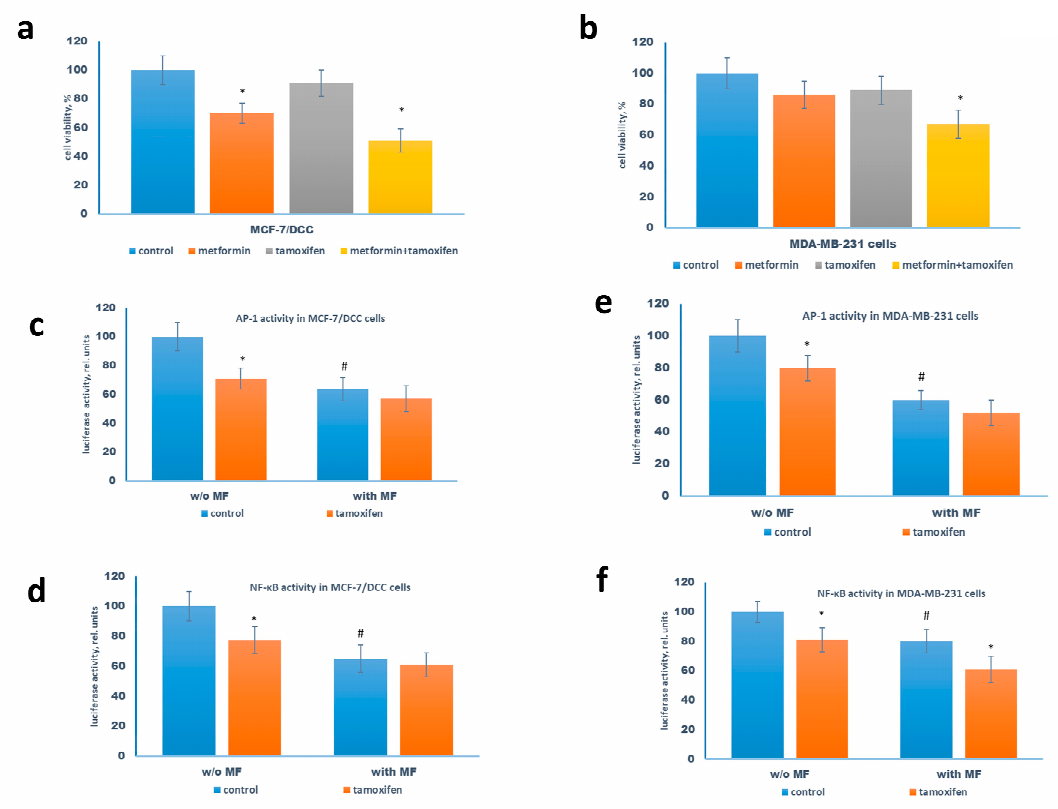
Figure 7. The sensitivity of MCF-7/DCC cells and MDA-MB-231 cells to tamoxifen. ( a , b ) Growth response. The cells were treated without or with 5 µM tamoxifen in the presence or absence 2 mM metformin for 3 days in phenol-free DMEM medium with 10% DCC (MCF-7/DCC cells) and in the standard DMEM medium with 10 % FCS, and the amount of the viable cells was counted by the MTT test. ( c – f ) Reporter assay. The cells were pretreated with or without 2 mM metformin for 2 days, then the cells were transfected with the AP-1 ( c,e ) or NF- κ B ( d,f ) plasmid containing the luciferase reporter gene under the AP-1 or NF- κ B-responsive elements, respectively, and β -galactosidase plasmid. Three hours after transfection the cells were treated with 2 mM metformin and 5 µM tamoxifen for 24 h. The luciferase and β -galactosidase activities were determined as described in Materials and Methods. Data represent the mean value ± SD of three independent experiments. p < 0.05: * versus respective control, # versus control cells w/o metformin.